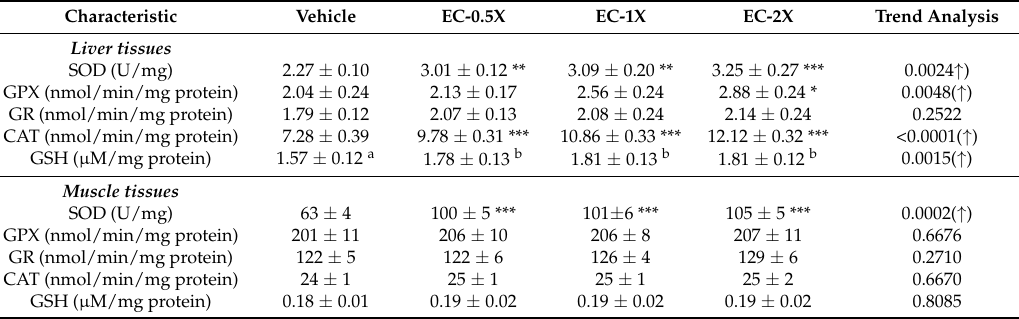
Table 4. Effect of EC supplementation on liver and muscle antioxidant